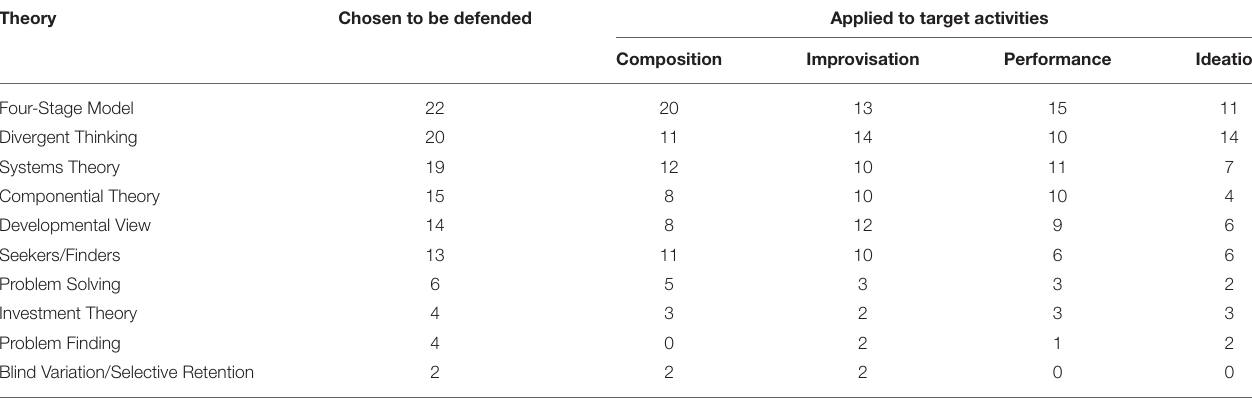
TABLE 3 | Numbers of participants defending the theories in their essays and applying them to the four musical activities ( N = 47). Theory Chosen to be defended Applied to target activities Composition Improvisation